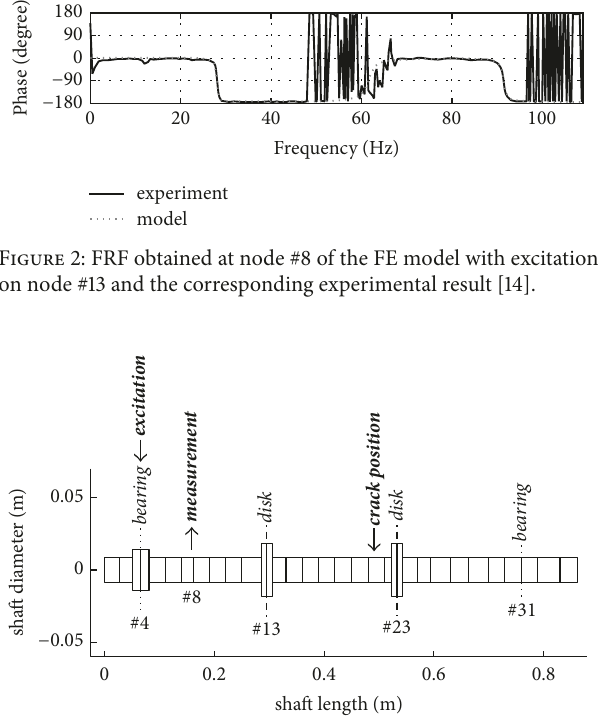
Figure 3: Location of excitation and measurement points for the FE